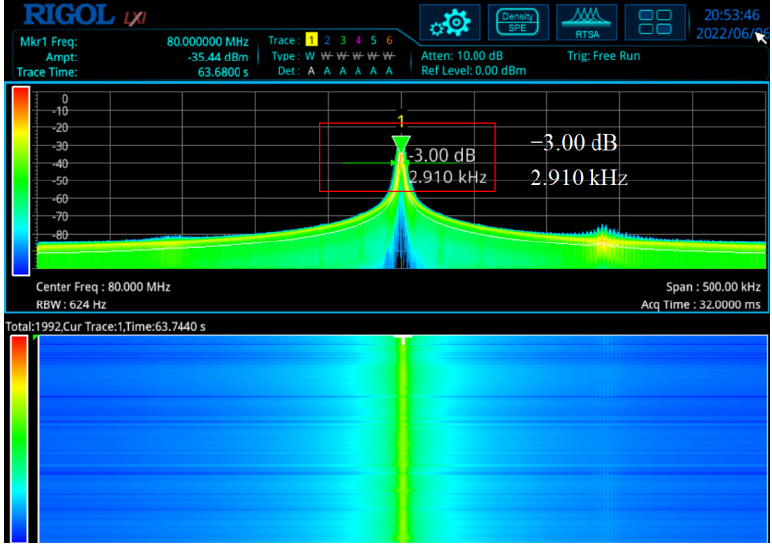
Figure 6. ( a ) The fiber laser linewidths are 4.97 KHz and 1.46 KHz in a partial un-shielded condition, and ( b ) The comparison of fiber laser linewidths of fully shielded and partially un-shielded conditions.